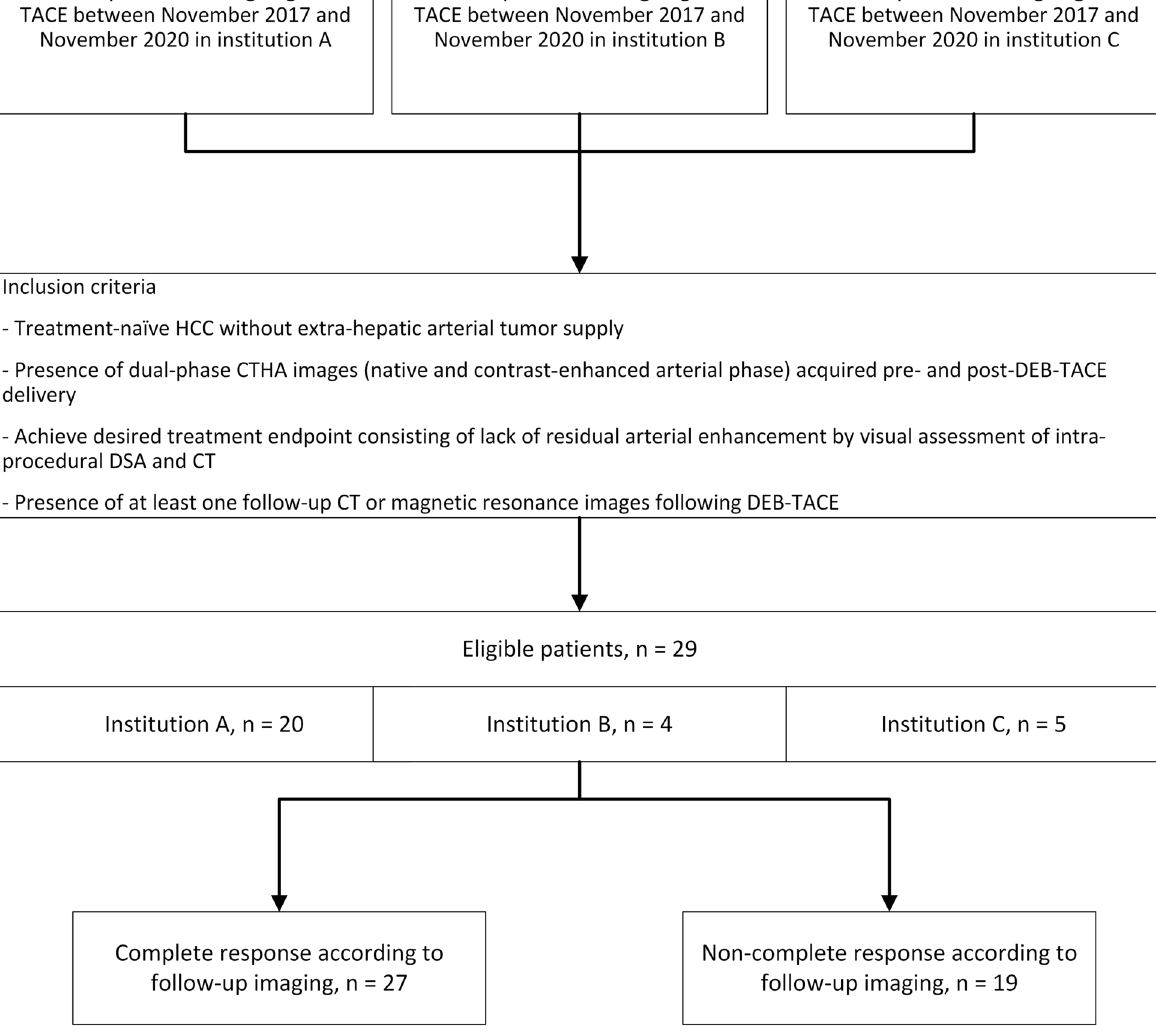
Fig. 1 Participant flowchart for